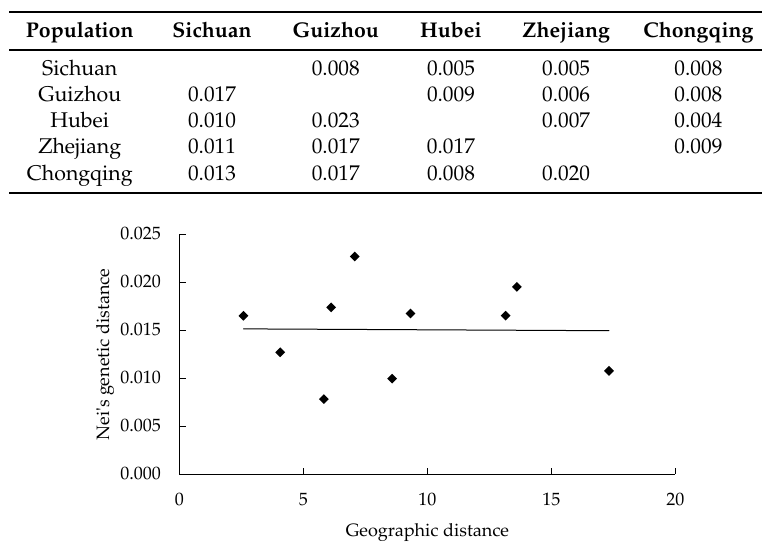
Table 4. Nei’s standard genetic distances (lower diagonal) and pairwise Fst values (upper diagonal) between populations.